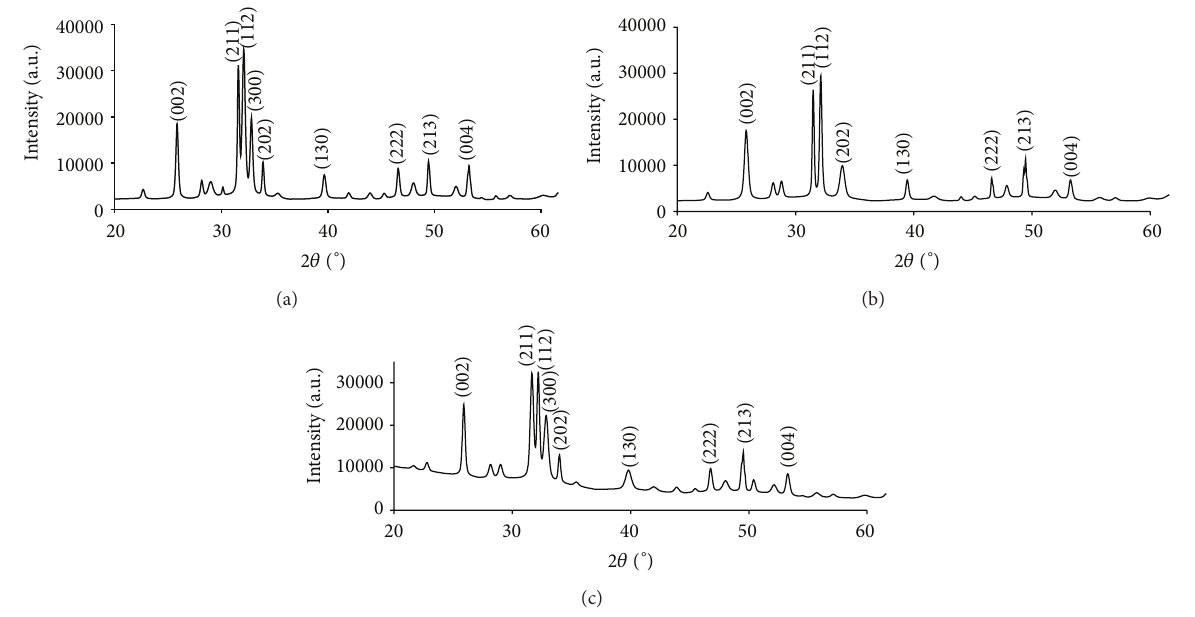
Figure 1: X-ray diffraction patterns of powder samples (a) dHA-900, (b) cHA-900, and (c)